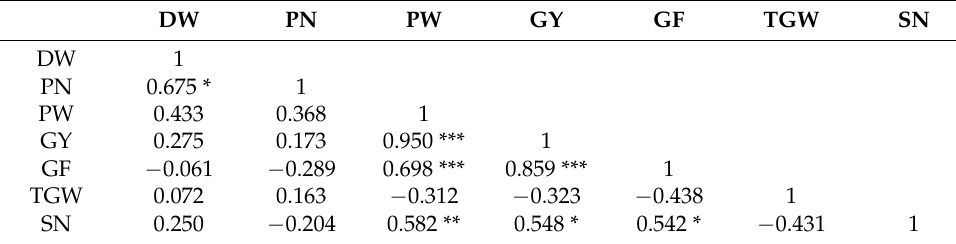
Table 4. Pearson correlation coefficients between grain yield and ancillary traits of Koshihikari and NILs under salt stress conditions in 2018. Values are mean ± standard error (n = 4). *, **, and *** indicate significant differences at the 5%, 1%, and 0.1% levels, respectively. DW PN PW GY GF TGW SN DW 1 PN 0.675 * 1 PW 0.433 0.368 1 GY 0.275 0.173 0.950 *** 1 GF − 0.061 − 0.289 0.698 *** 0.859 *** 1 TGW 0.072 0.163 − 0.312 − 0.323 − 0.438 1 SN 0.250 − 0.204 0.582 ** 0.548 * 0.542 * − 0.431